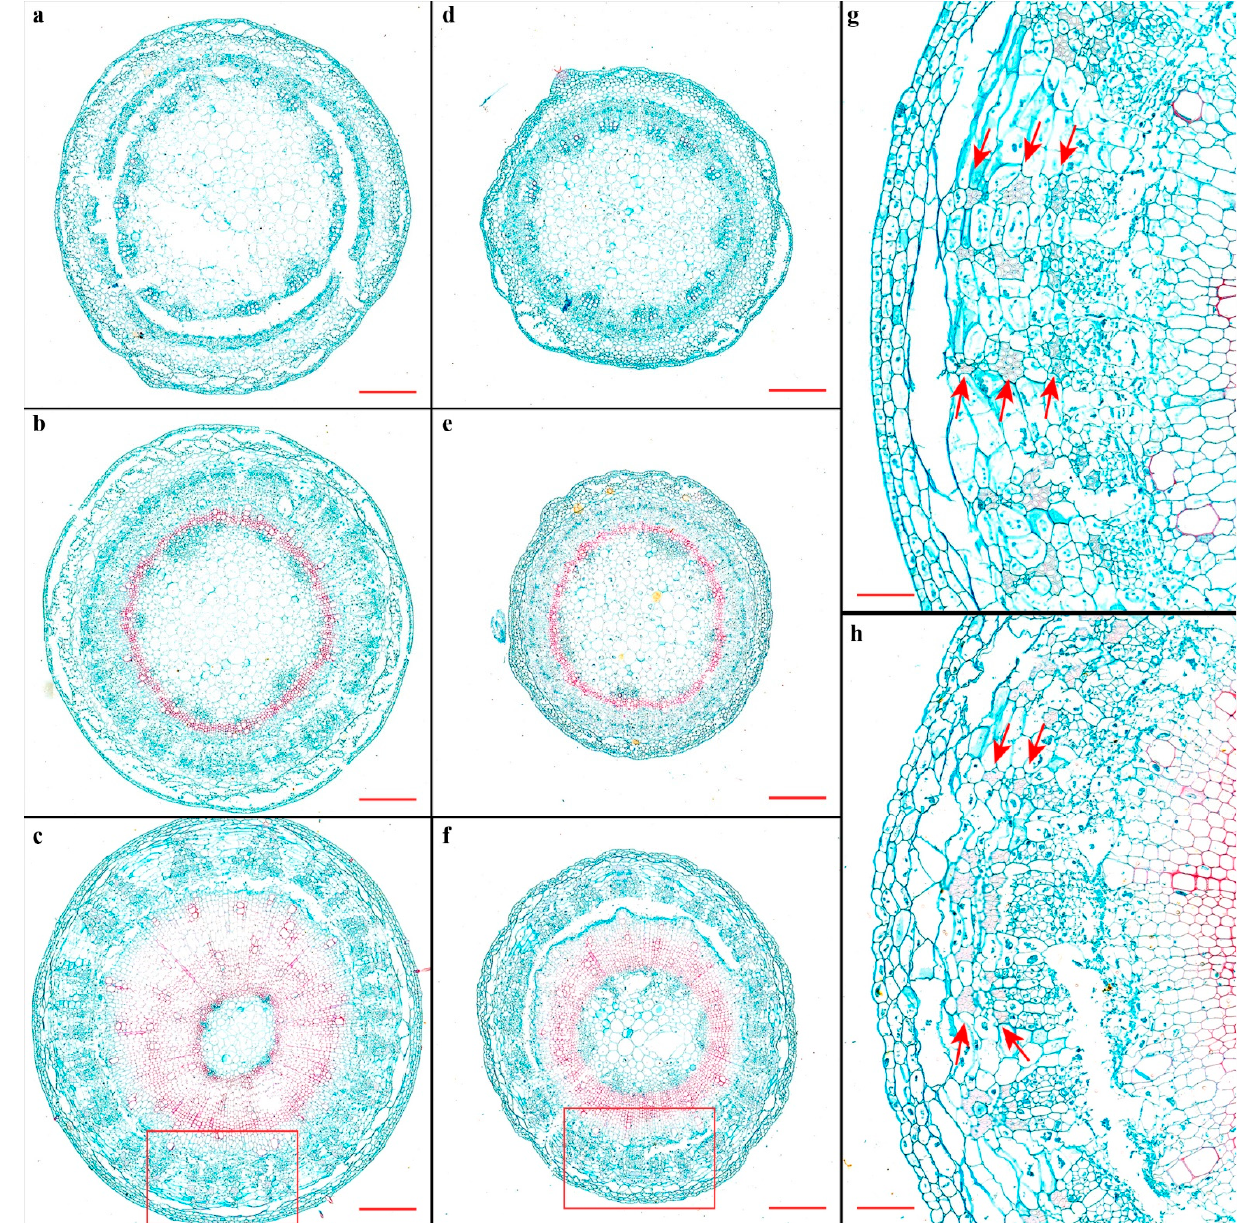
Figure 5. Representative slices of kenaf stems. The slices obtained from the top ( a , d ), middle ( b , e ), and bottom ( c , f – h ) parts were respectively displayed, in which the ( a – c ) and g are kenaf stem parts at normal conditions, and the rest are under salinity stress. ( g,h ) represent the enlarged area of the red rectangles in c and f , respectively. The red-stained cells are lignified, and the red arrows indicated the kenaf fiber cells. Bars in ( a ) to ( f ) are 200 μ m, while in ( g,h ) are 50 μ m.